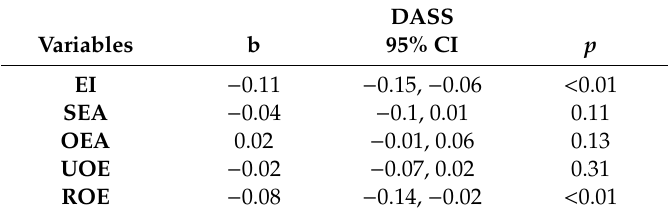
Figure 1. Mediator model examining the indirect relationship between MT and psychological distress through EI total score. Numbers in parentheses represent indirect e ff ects for mediator variable. ** p < 0.01. Table 2. Indirect e ff ects of MT on psychological distress through mediating variables.